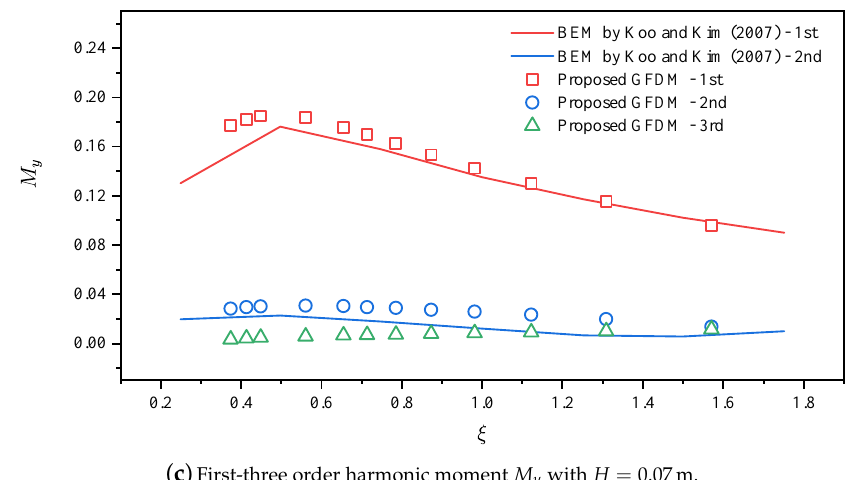
Figure 8. Numerical comparisons of the first-three order harmonic components of the hydrodynamic loads acting on the body surface. F x is normalized by ρ gLd ( H /2 ) , F z by ρ gLB ( H /2 ) , and M y by ρ gLBd ( H /2 ) with L = 1m, B = 0.5m, d = 0.25m and H = 0.07m (or H =